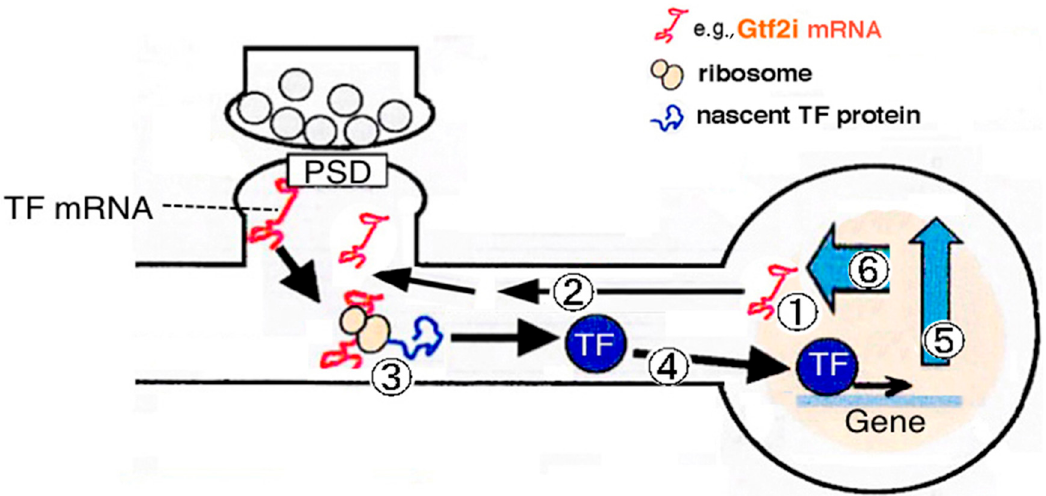
Figure 1. Transcription, targeting, and the fate of postsynaptically localizing mRNAs that encode transcription factors. The mRNA encoding Gtf2i is one of the postsynaptic density (PSD)-associated mRNAs. It is hypothesized that locally translated transcription factors at the postsynapse act as signal transduction molecules transmitting synaptic signals into the nucleus. 1. Transcription of its own gene; 2. Targeting mRNA into the dendrite; 3. Postsynaptic local translation; 4. Synapse-to-nucleus transmission of protein products; 5. Modulated transcription of downstream genes in the nucleus; 6. Feedback effects on synapse (Multiple processes/pathways are plausible; however, their details are still unknown). TF: transcription factor.